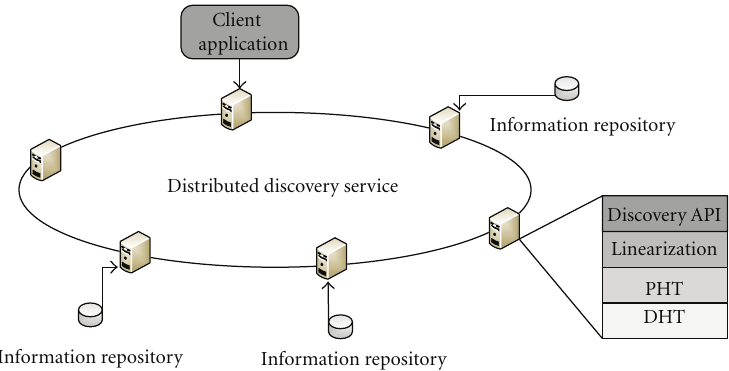
Figure 1: Functional view of the proposed Distributed Discovery